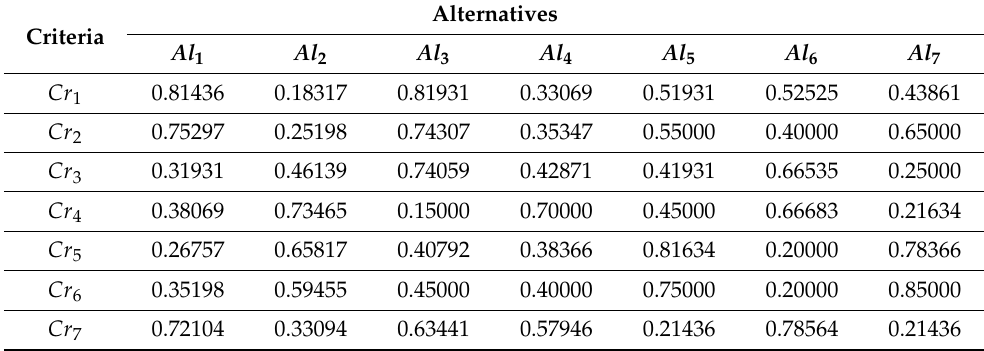
− − y y , ϕ j , , and φ ju . j u